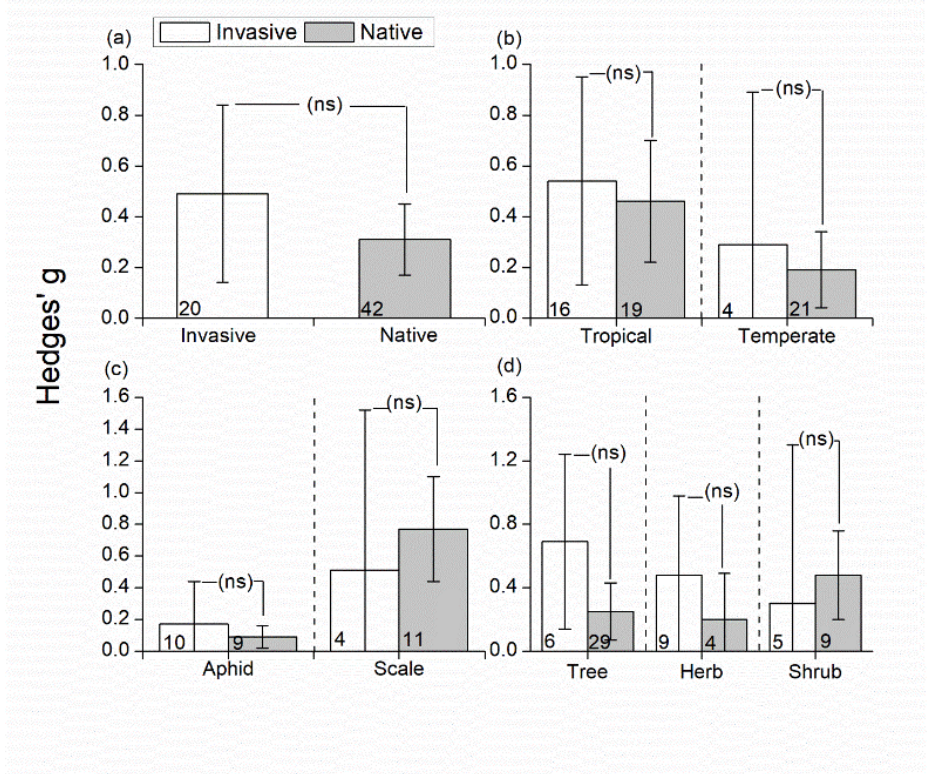
Figure 4. Mean effect size (Hedges’ g) and 95% confidence interval of the effect of exclusion of invasive or native ants on herbivore abundance ( a ) under different climatic zone ( b ), Hemiptera type ( c ), and plant growth form ( d ). The sample sizes for each category are shown in the box. “ns” not significant.